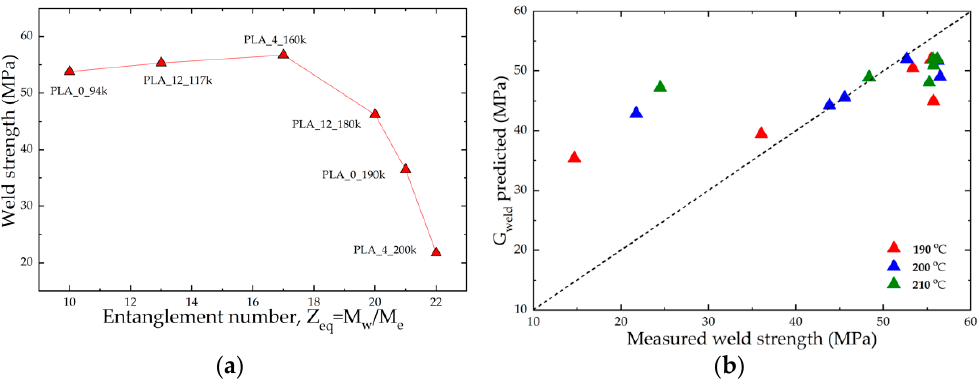
Figure 9. ( a ) Weld strength measured for samples printed at 200 °C and 120 mm/s as a function of 𝑍 (cid:3032)(cid:3044) = 𝑀 (cid:3050) /𝑀 (cid:3032) ; ( b ) Weld strength, 𝐺 (cid:3050)(cid:3032)(cid:3039)(cid:3031) , predicted by the model (see Equation (5)) as a function of measured weld strength for all the explored nozzle temperatures and print